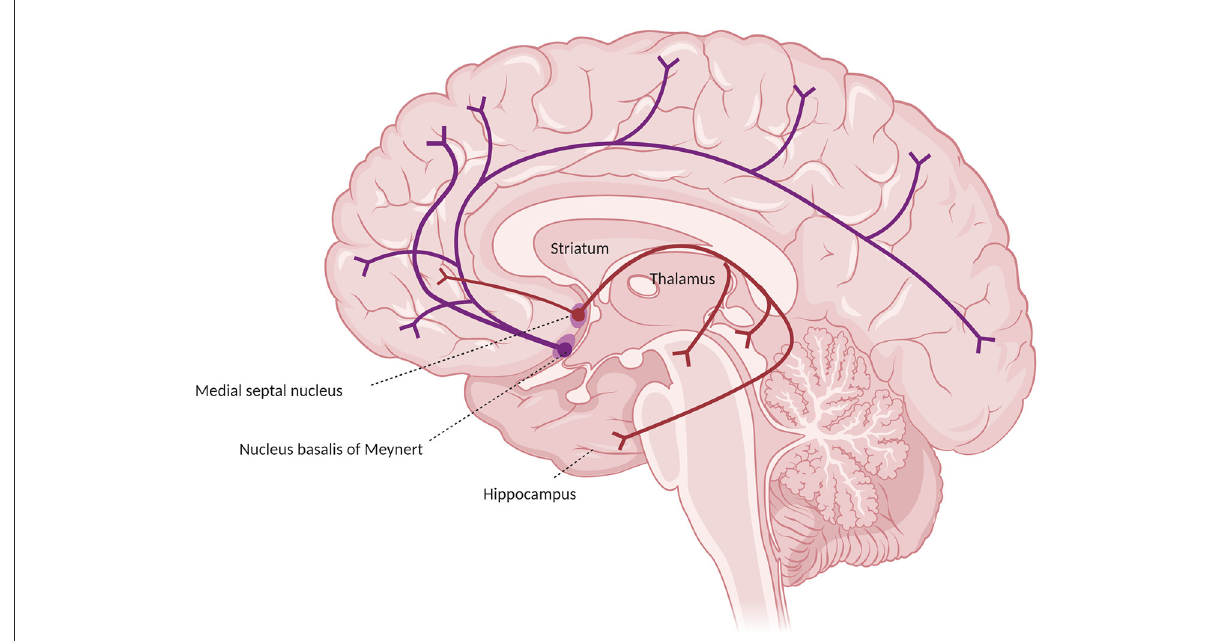
FIGURE1 Major cholinergic pathways in the brain, starting from the basal prosencephalon, showing the projections from the nucleus basalis of Meynert (in blue) and from the medial septal nuclei (in